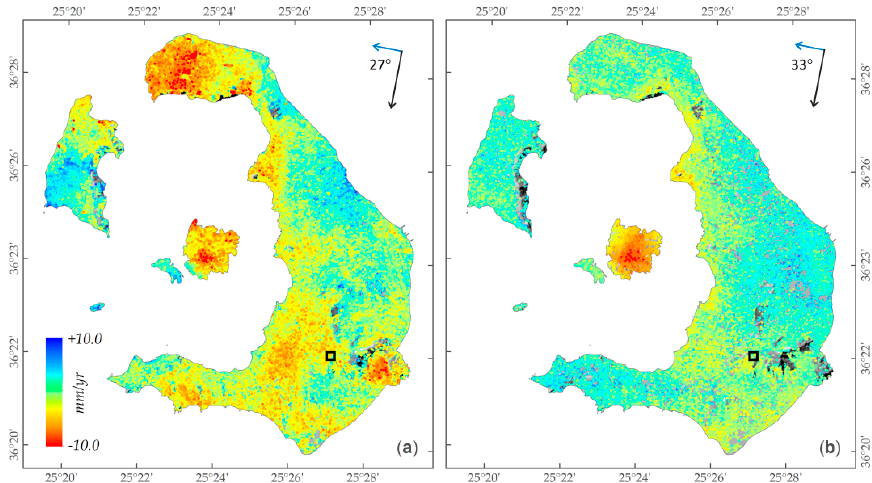
Figure 8. PSI average LOS velocities for ( a ) Radarsat-2 data (2012–2016), and ( b ) TerraSAR-X data (2012–2013), obtained from GEP [53]. The line-of-sight and azimuth directions of the satellite are displayed by blue and black arrows, respectively. Values in degrees correspond to the incidence angles.